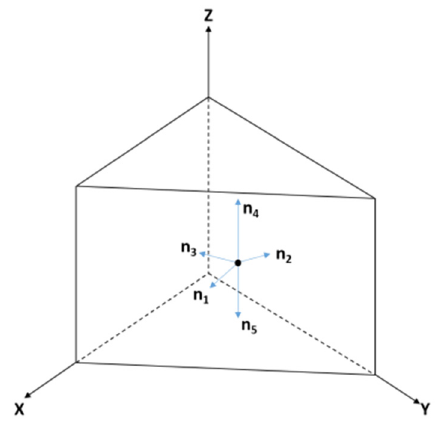
Figure 4. Schematic of prismatic